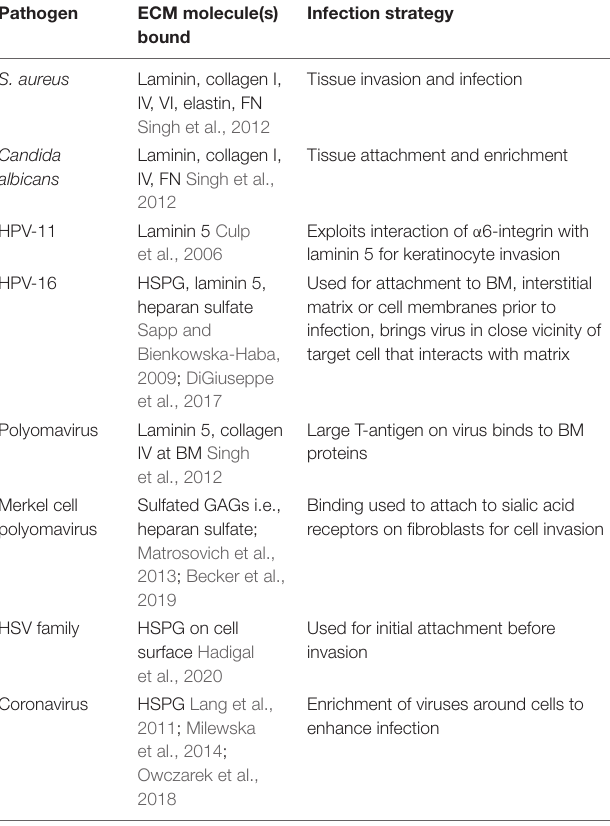
TABLE 2 | Pathogens exploiting the ECM for invasion.